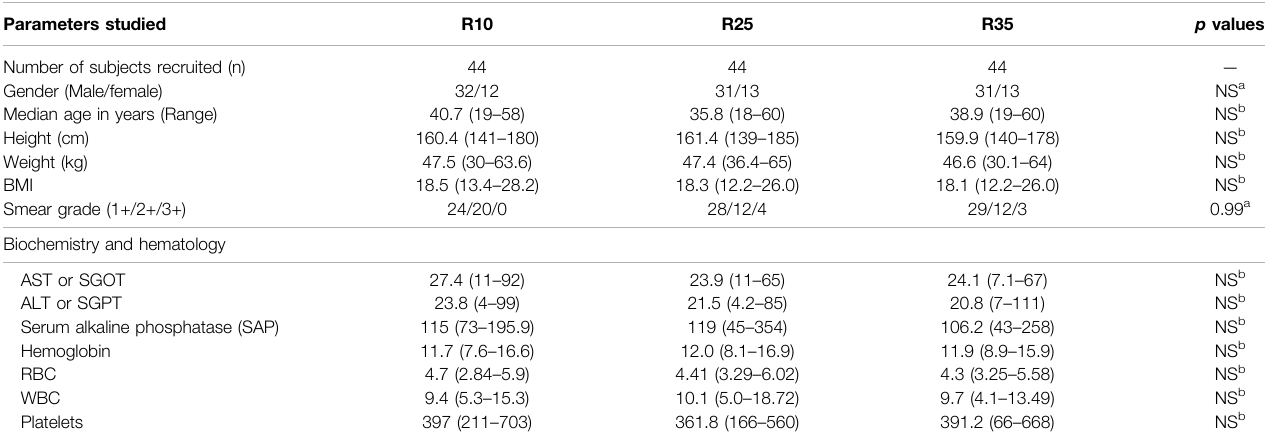
TABLE 2 | Demographics of the study population for APPs and